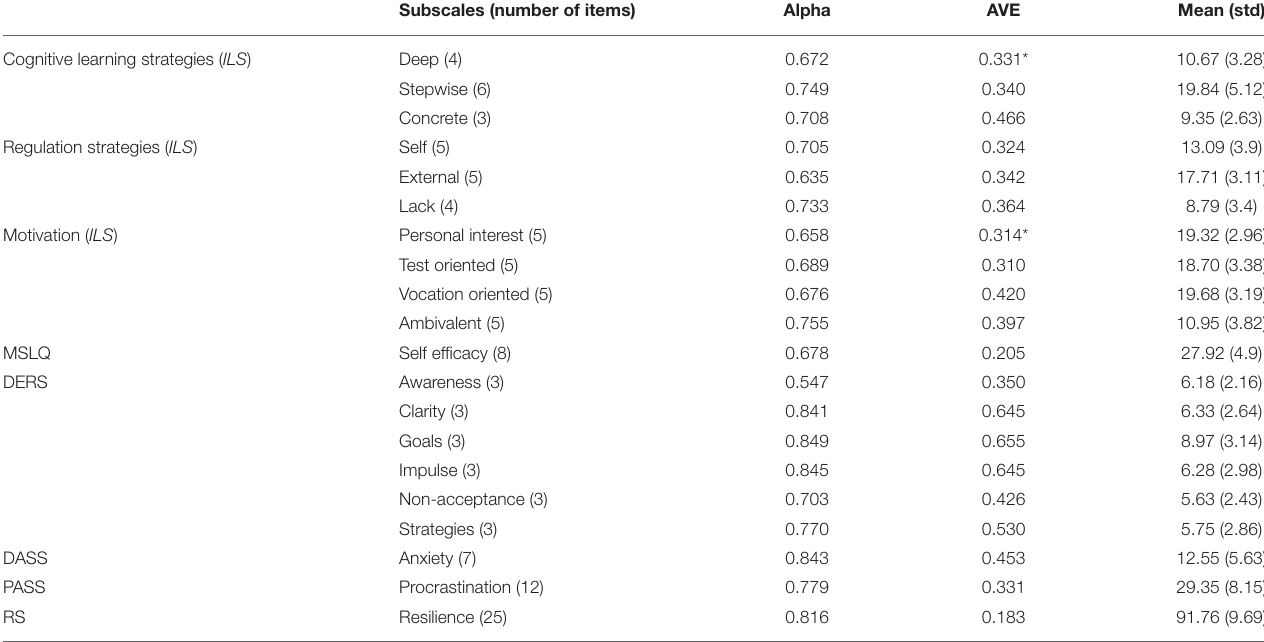
TABLE 2 | Cronbach’s alpha, average extracted variance (AVE) and descriptive statistics, for the 20 subscales. Subscales (number of items) Alpha AVE Mean (std) Cognitive learning strategies ( ILS